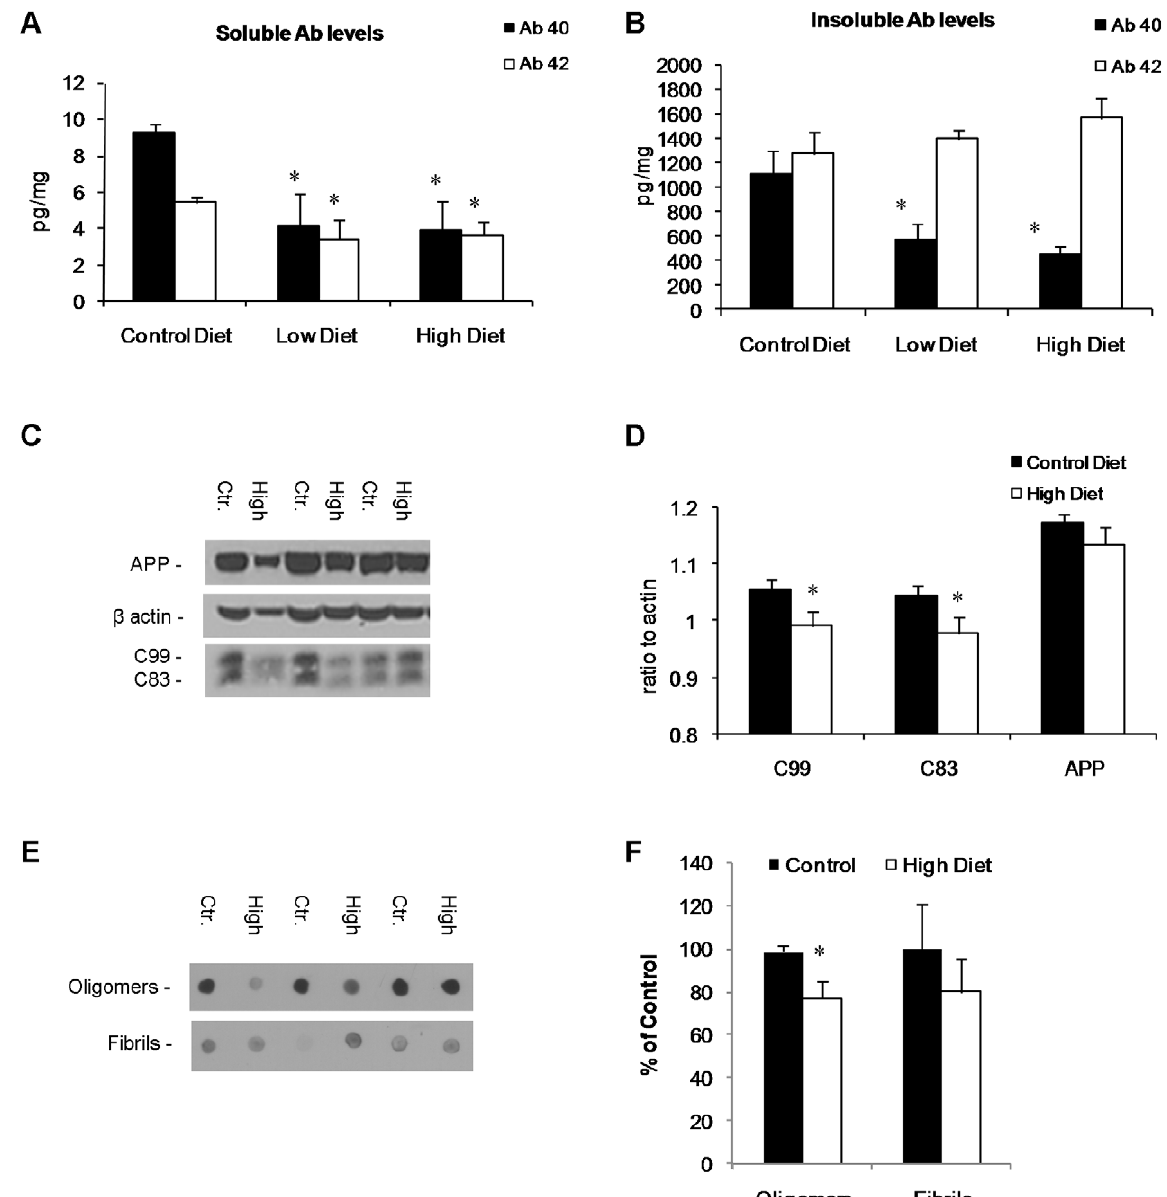
Figure 3. Medical food cocktail diet reduces A b levels and decreases aggregation. Soluble (A) and insoluble (B) A b 40 and A b 42 levels were measured from Tg2576 whole brain homogenates from animals treated for 6 months with medical food cocktail or vehicle. A) Soluble A b levels were significantly reduced with medical food cocktail diet in Tg2576 mice. B) Insoluble A b 40 levels were also significantly reduced with medical food cocktail diet in Tg2576 mice. C) Western blot analyses of protein extracts from whole-brain homogenates of Tg2576 mice treated for 6 months with either high dose medical food cocktail or vehicle shown as alternating lanes. Steady state levels of APP were unaffected by treatment, but APP CTF’s C83 and C99 were reduced by medical food cocktail treatment. D) Quantification of (C) normalized to b -actin levels as a loading control. E) Dot blot analyses of brain homogenates from Tg2576 mice treated for 6 months with either high dose medical food cocktail or vehicle for A b oligomers or A b fibrils, using conformation specific antibodies, or western blot analyses for A b *56 using 6E10, shown as alternating lanes. Reductions in both A b oligomers and A b *56 were seen with treatment. F) Quantification of (E). Error bars indicate SEM. * indicates significance (p , 0.05) for control Tg2576 mice vs. high dose medical food cocktail treated Tg2576 mice. To assess levels of low molecular weight oligomeric and soluble fibril A b species we used the conformation specific antibodies A11 and OC respectively. Dot blot analysis showed a 20% reduction of soluble oligomers in the brains of Tg2576 animals treated with the high combination diet (Figure 2E, F), but no differences in soluble